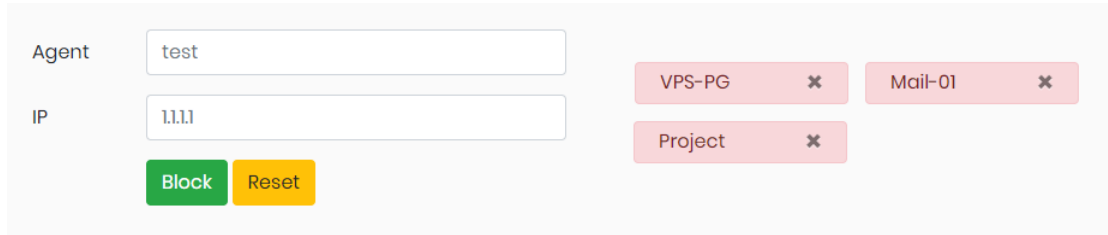
Figure 6. Layout of Active-response Manager User Interface (UI) to block IP.